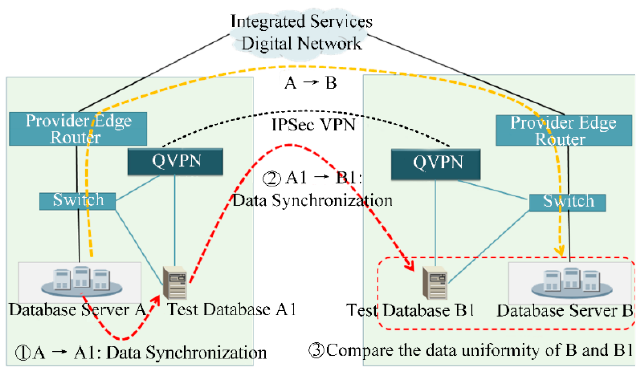
Figure 10. Disaster recovery backup based on QKD.